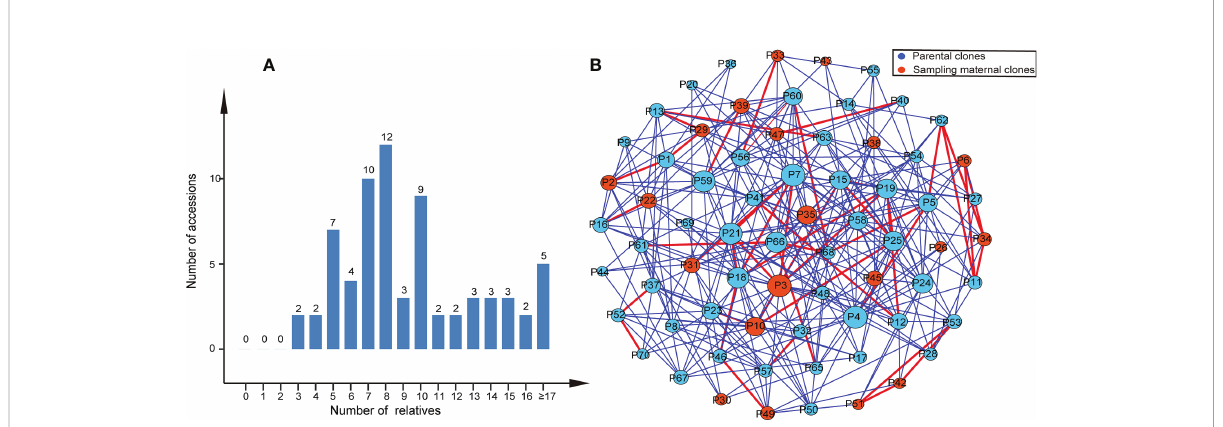
FIGURE 3 Relatives within the Chinese fi r germplasm collection. (A) Histogram of the number of relatives in the third-generation seed orchard of Chinese fi r. (B) A network of parental clones showing connections between relatives. The two circles connected by the red lines represent parental clone pairs were fi rst-degree relatives, and the blue lines represent that parental clone pairs were related but probably not fi rst-degree relatives. The larger the circle, the more parental clones were related to